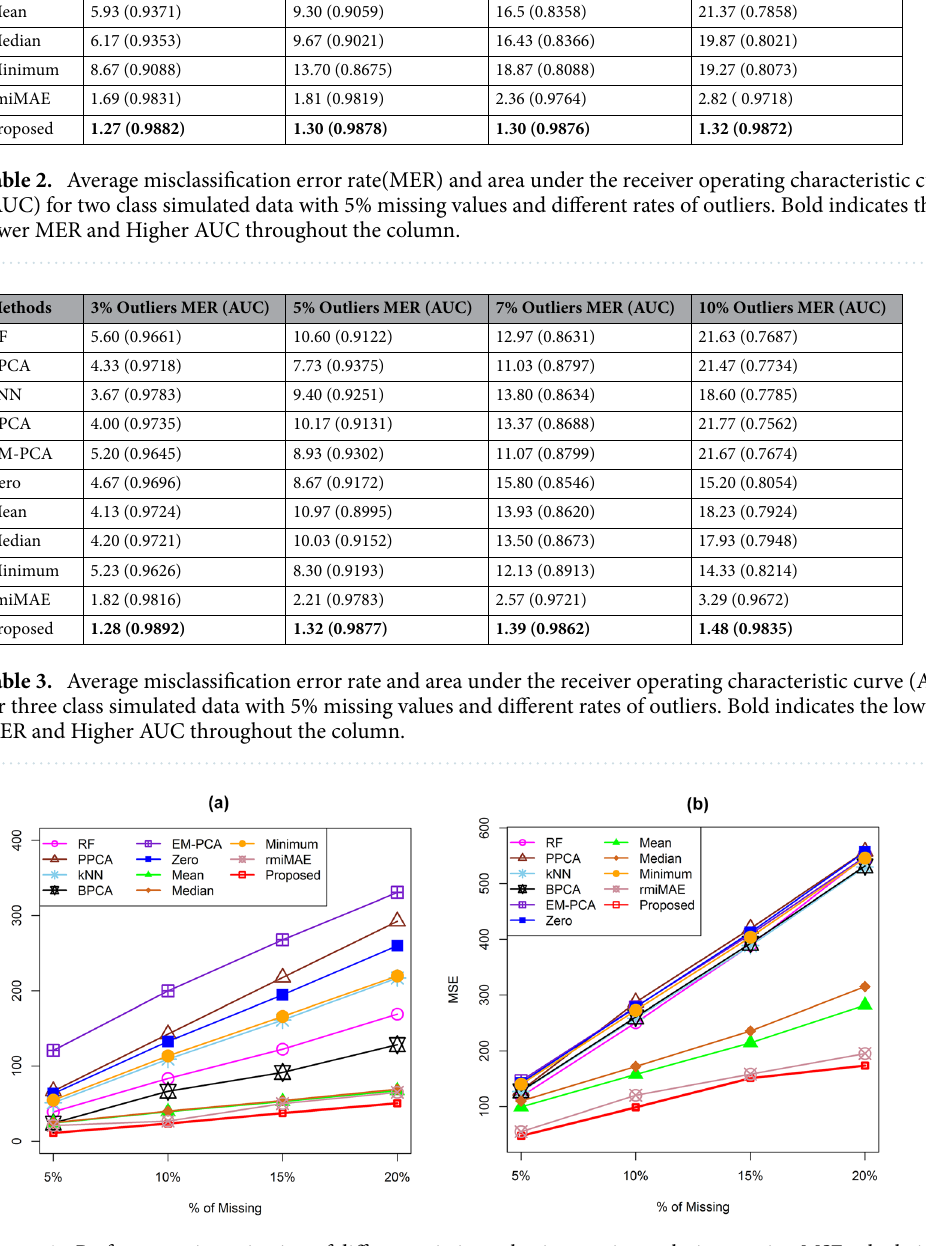
Figure 4. Performance investigation of different missing value imputation techniques using MSE calculation for different rates of missing values of ( a ) Human Cachexia dataset and ( b ) treated